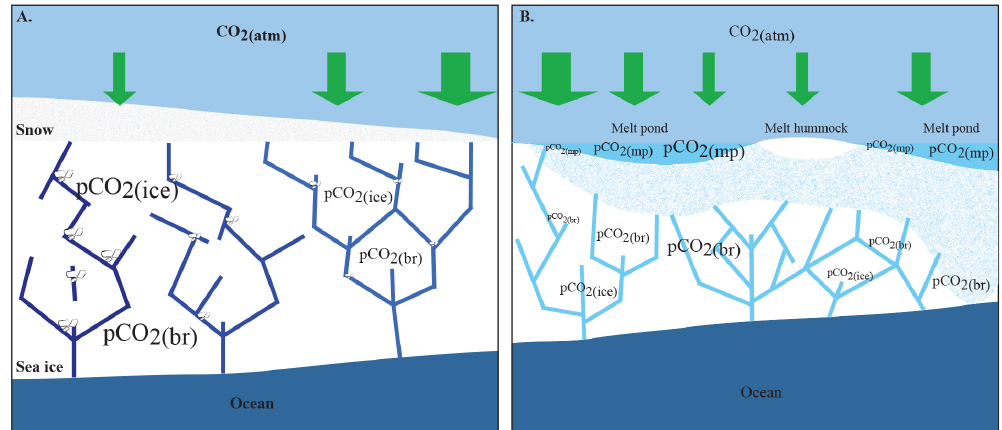
Figure 10. Schematic illustration of the inorganic carbon dynamics of melt-pond-covered first-year sea ice. (a) The increase of the ice temperature and the decrease of the salinity, associated with the dissolution of ikaite crystals, promote the decrease of the bulk ice and brine p CO 2 . (b) Formation of melt ponds at the surface of the ice and percolation of meltwater into the ice matrix further decreases the p CO 2 with episodes of partial recovery, due to surface exchanges with the atmosphere. The p CO 2 level is indicated by the size of the writing. The intensity of the CO 2 uptake is indicated by the size of the